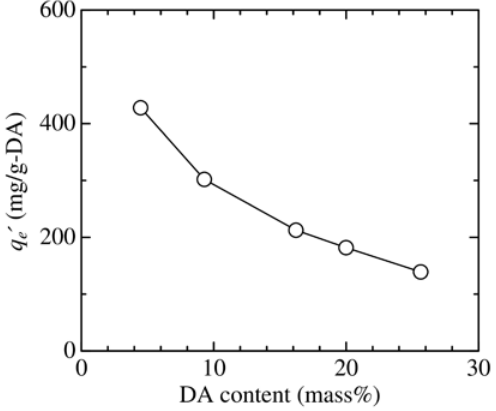
Figure 8. MO equilibrium adsorption capacity per unit mass of DA (dosage = 0.5 g/L, initial concentration = 20 mg/L, initial pH = 6.9, temperature = 301 K).